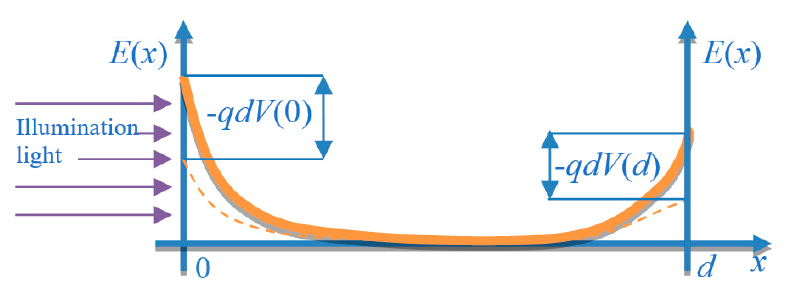
Figure 2. The changes of the energy band bending occurring on both surfaces.